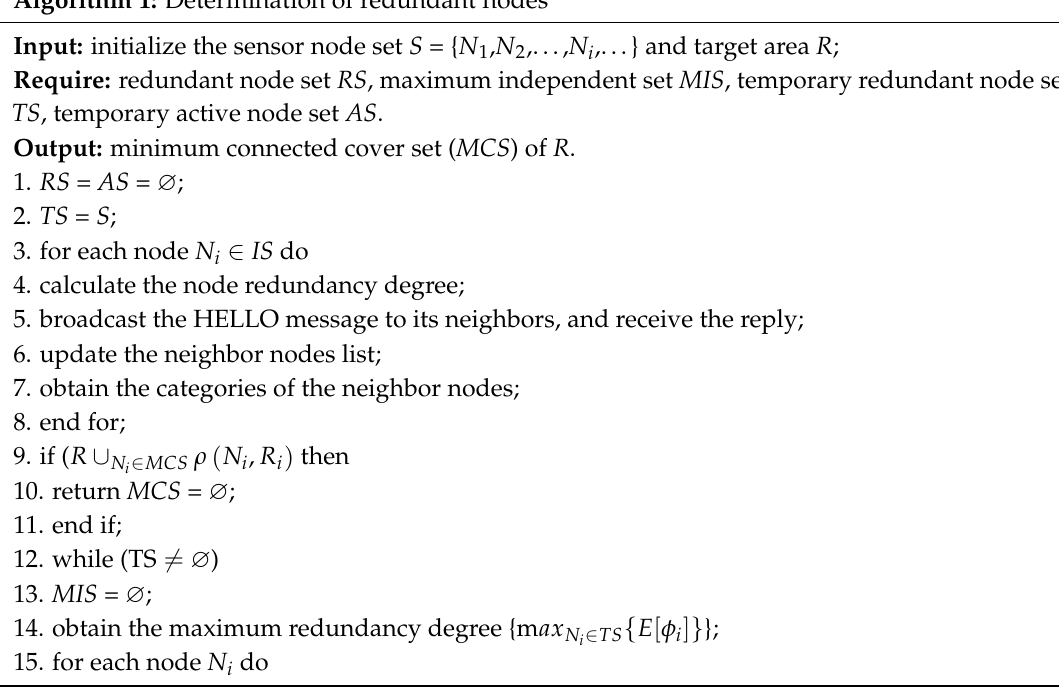
Algorithm 1: Determination of redundant